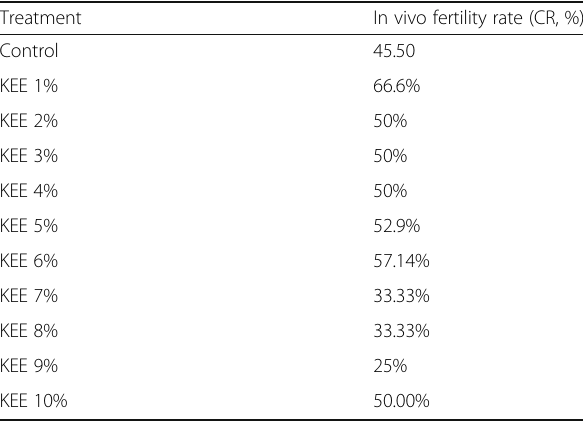
Table 3 Effect of Diospyros kaki enriched extender on a field conception rate test in buffalo